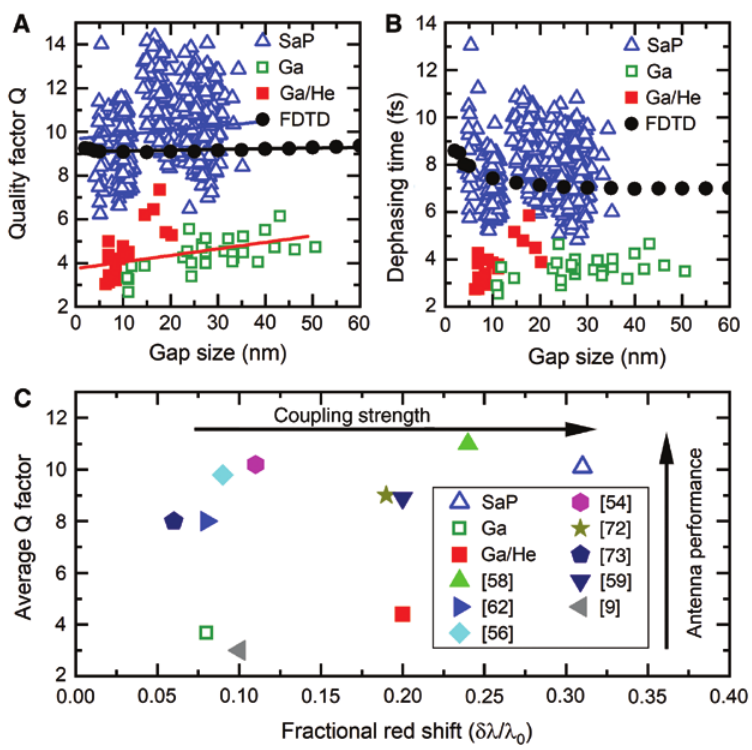
Figure 3: Nanorod dimer antennas performance. (A) Quality factor Q of the dimer antennas fabricated using SaP (blue triangles), Ga (green squares), and Ga/He (red squares) as a function of gap size. Results from FDTD simulations are shown as black circles. The lines are guides to the eye. (B) Dephasing time T of the antennas. (C) Comparative analysis of quality factors Q and fractional red shifts δ λ / λ chemical synthesis and lithography techniques. SaP allows one to fabricate strongly coupled antennas with high-quality